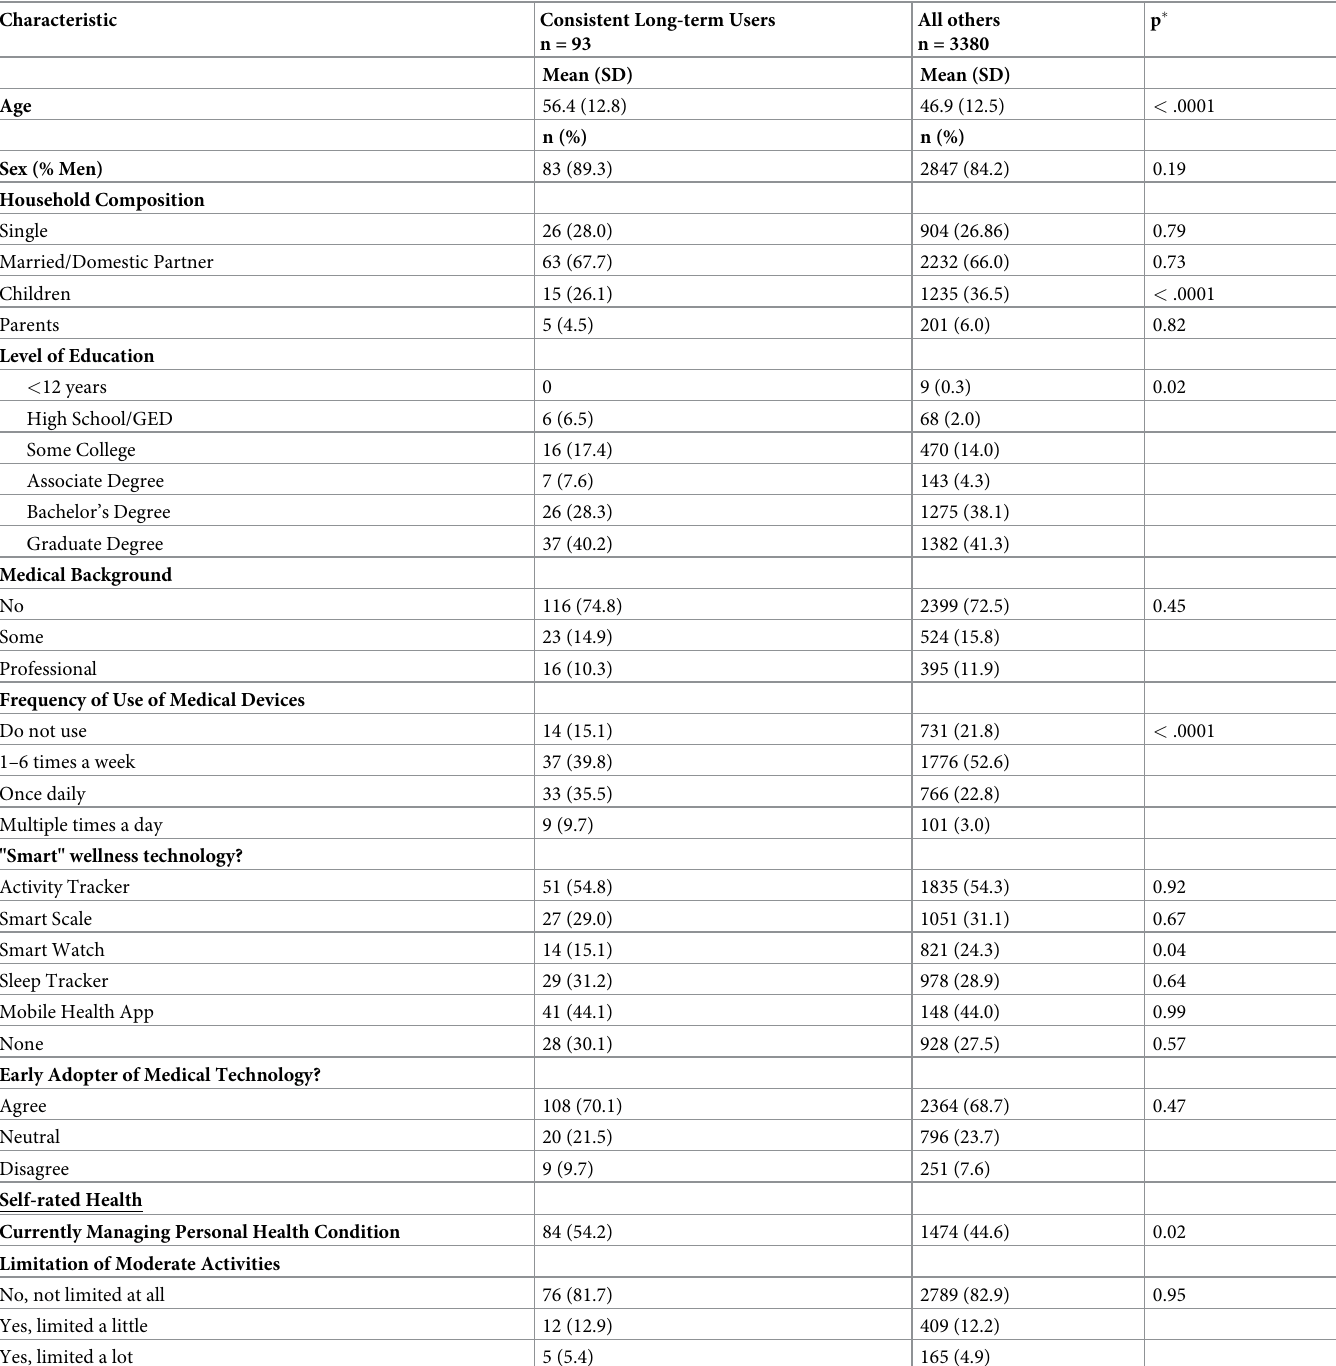
Table 3. Baseline characteristics of participants with linked device use by frequency of device